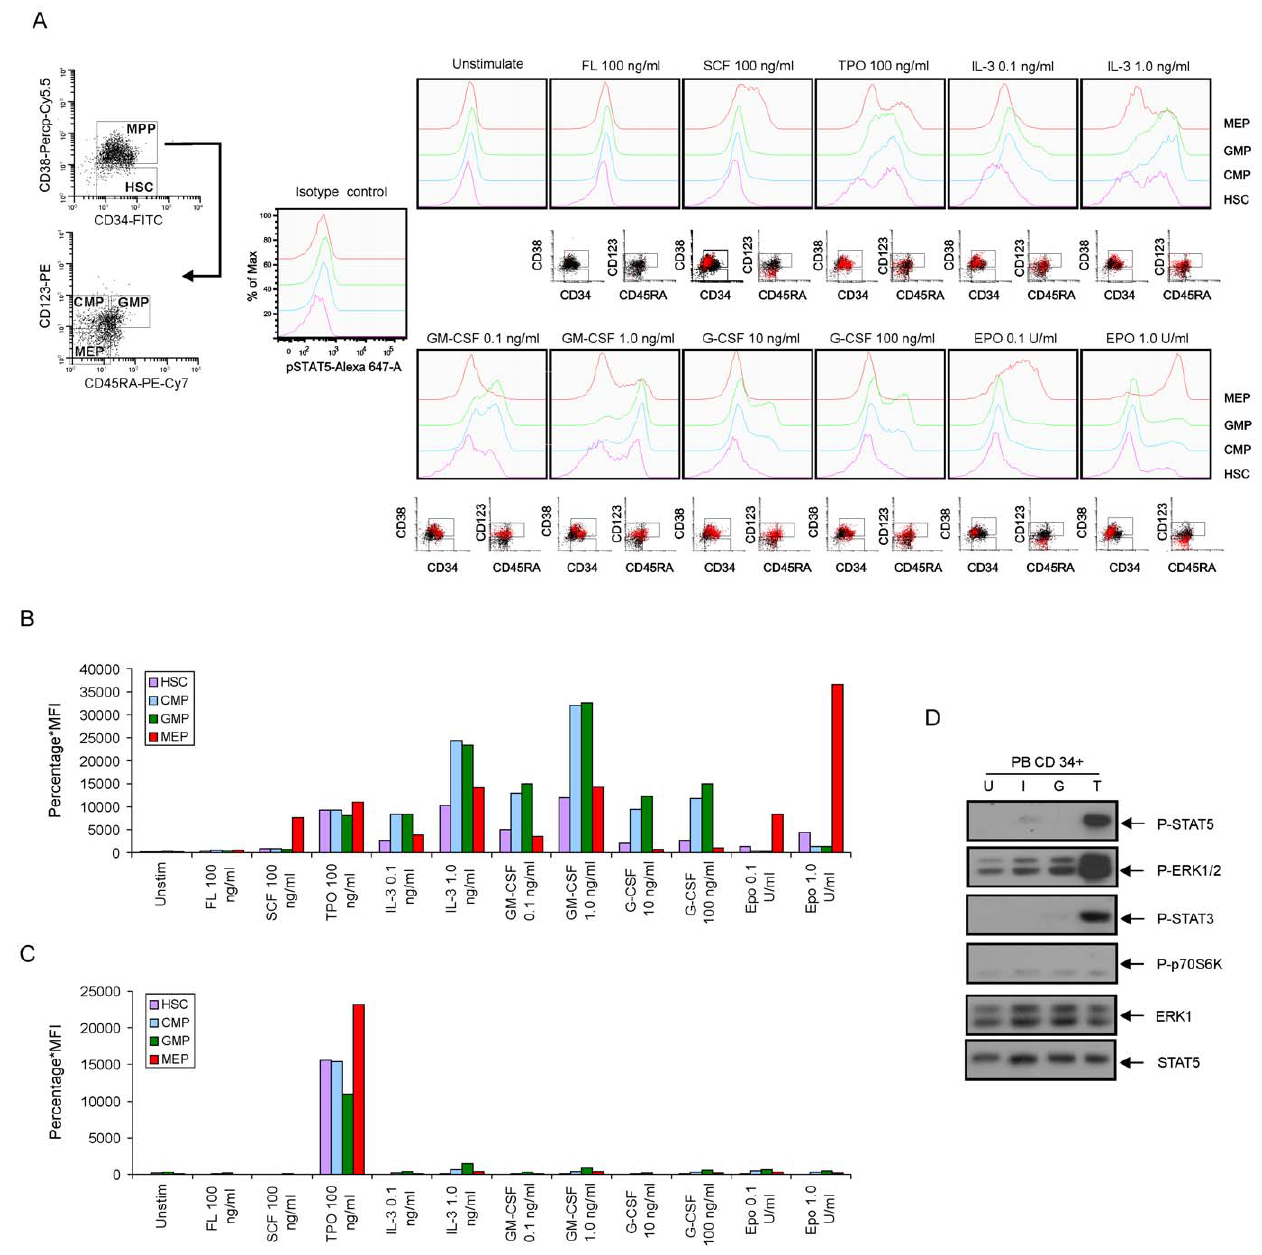
Figure 1. STAT5 phosphorylation in defined stem and progenitor cell populations in normal hematopoietic cells. (A) Normal CD34 + cells isolated from cord blood (CB) were expanded in HPGM supplemented with 100 ng/ml SCF, FL and TPO for 3 days. Cells were washed and cytokine-depleted in HPGM overnight and then stimulated with indicated cytokines for 15 minutes, followed by intracellular FACS. The scatter properties and gating schemes are shown. The red dots represent the cells with activated STAT5 upon stimulation. (B) Overview of cytokine responses in STAT5 activation in CB CD34 + cells quantified as the percentage of positive cells multiplied with the mean fluorescence intensity (MFI). (C) Normal CD34 + cells derived from mobilized peripheral blood (PB) were suspended in HPGM for 2 hours, followed by cytokine stimulation and intracellular FACS. (D) 1 6 10 6 /ml PB CD34 + cells were isolated and suspended in HPGM for 2 hours. Cells were stimulated with 1.0 ng/ml IL-3 (I), 100 ng/ml G-CSF (G) or 100 ng/ml TPO (T) for 15 minutes or left unstimulated (indicated as U), after which cell lysates were prepared and subjected to Western blotting using antibodies as indicated.